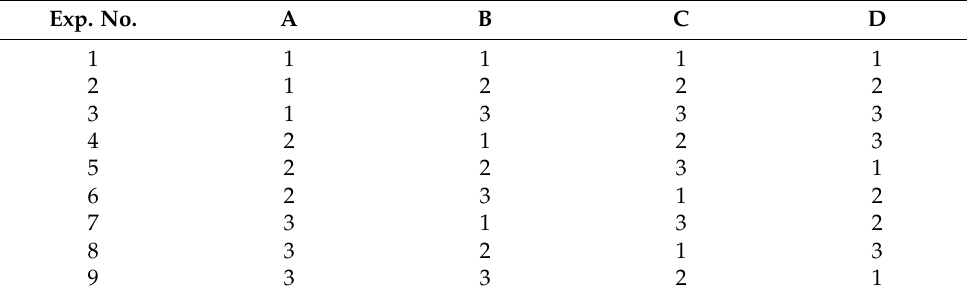
Table 4. The LP orthogonal array (3 4